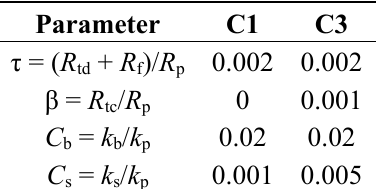
Table 2. Parameters used in the present investigation.